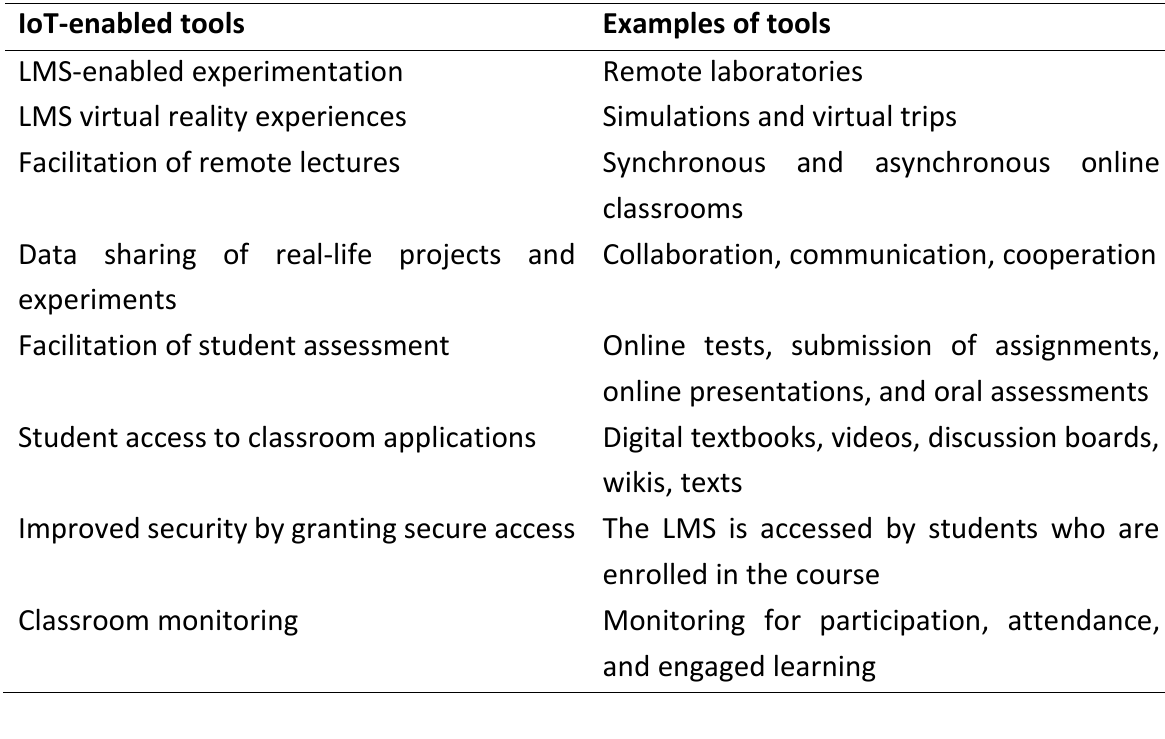
Table 1. Learning management system IoT-enabled